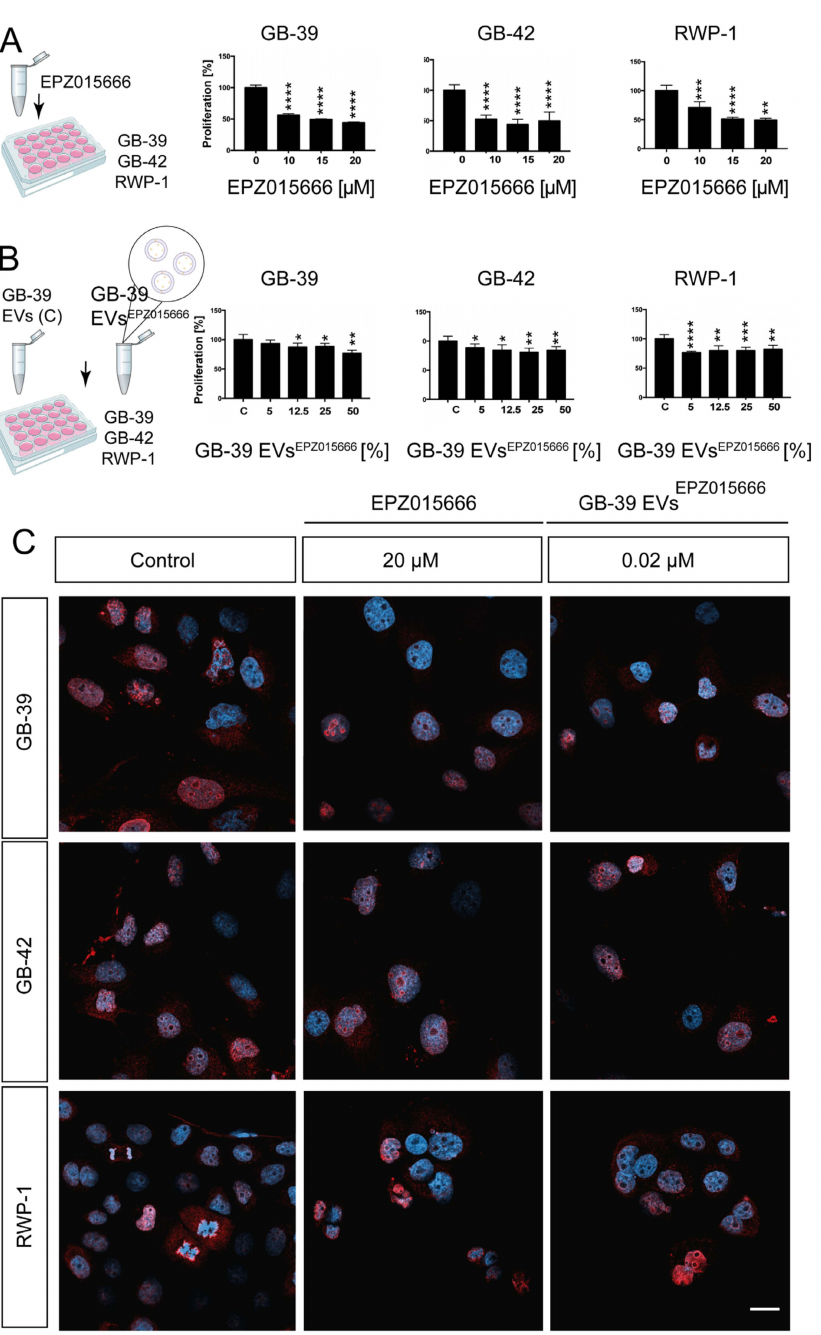
Figure 6. Cell proliferation effect of EPZ015666 in cancer cell lines. ( A ) Cancer cells were treated with increasing concentrations of EPZ015666, and their proliferation was measured. ( B ) Small EVs of GB-39 were loaded directly with a 15 µ M concentration of EPZ015666. Small EVs alone or serial dilutions of the loaded small EVs were applied to different cancer cell lines, and their effect on proliferation was measured. ( C ) Confocal images showing the expression of a proliferative marker and the decrease in cell density due to the EPZ015666 and GB-39 EVs EPZ015666 effect. Asterisks indicate the statistical significance of the results (* p < 0.05, ** p < 0.01, *** p < 0.001, **** p < 0.0001). Scale bar C, 20 µ m. EVs, extracellular